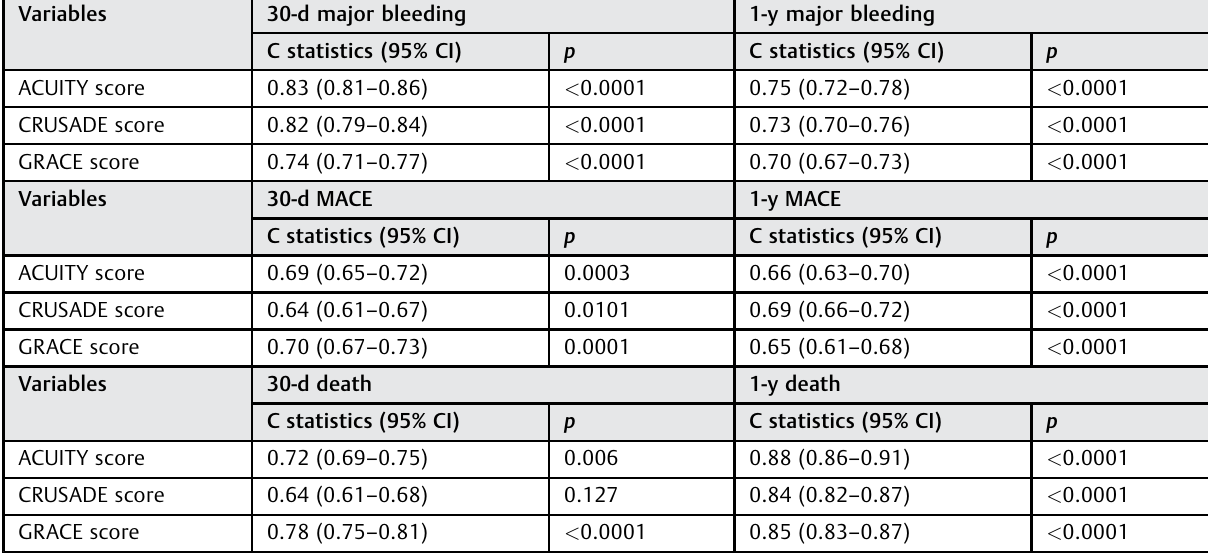
Table 2 Predictive performance of risk scores for major outcomes